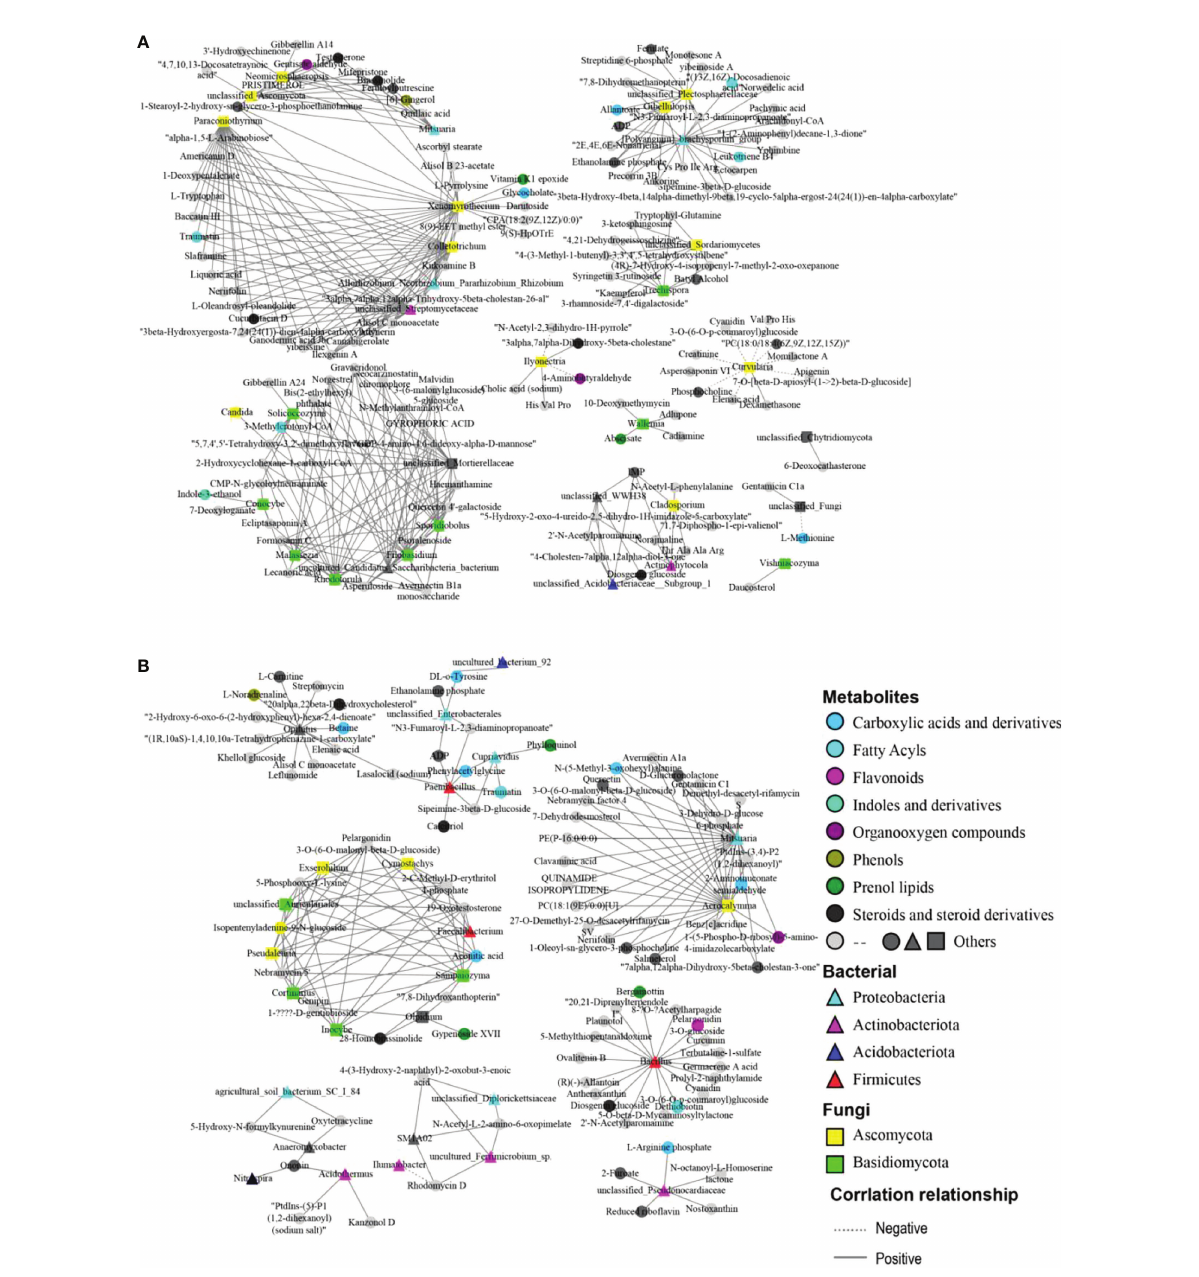
FIGURE 6 Co-occurrence network analysis among the different microbiota and metabolites from the roots (A) and the rhizosphere soils (B) of the female and male papaya. The triangles, squares and circles represented bacteria, fungi and metabolites, respectively. Different colors represented the classi fi cation of bacteria and fungi at the phylum level and metabolite HMDB classi fi cation. The straight line represented a signi fi cant positive correlation, while the dotted line represented a negative